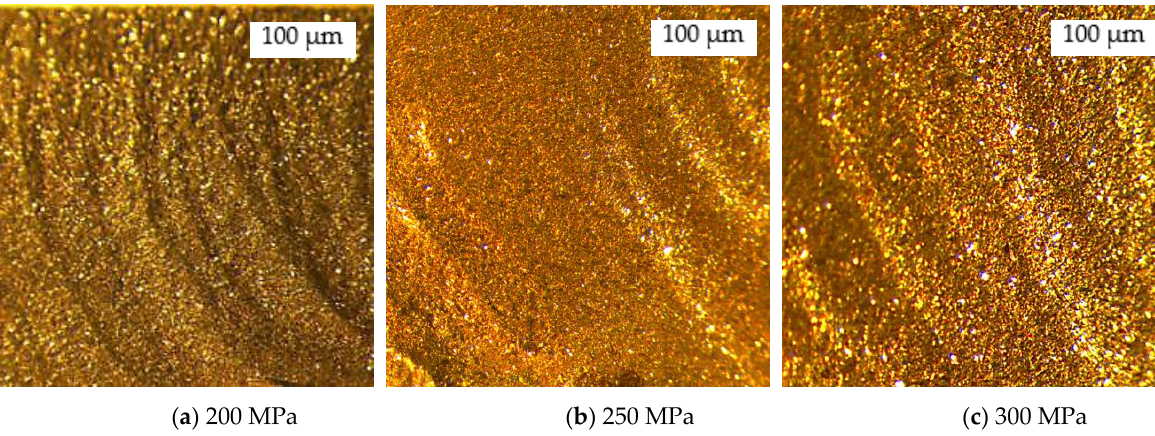
Figure 8. Topography of AISI 304L cut surface with 8 mm thickness using varied waterjet pressure.